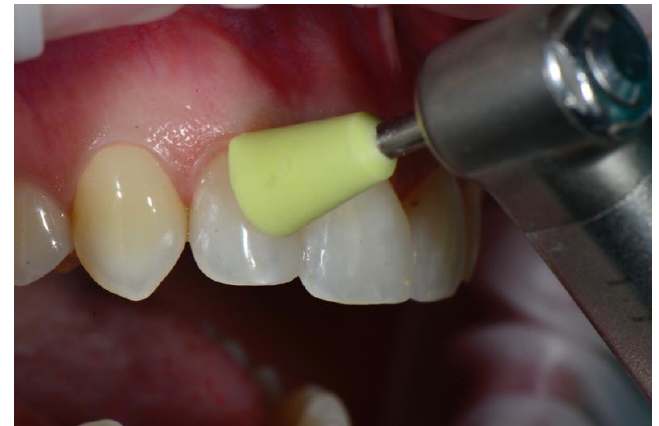
Figure 10. Finishing the margins.